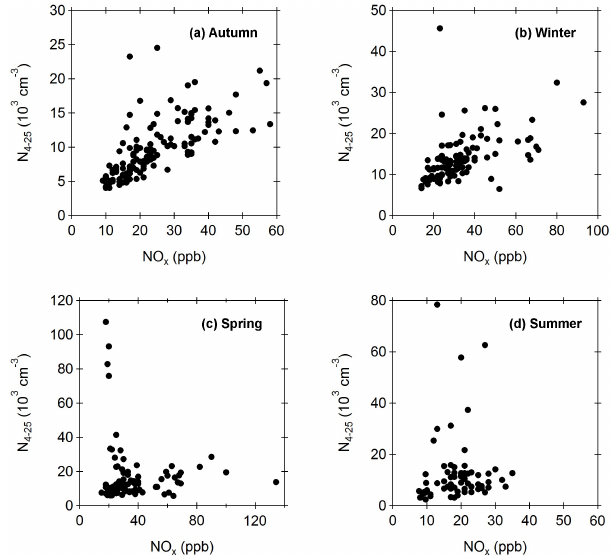
Figure 6. Scatter plots between hourly N 4 − 25 and NO x observed in (a) autumn, (b) winter, (c) spring and (d) summer at the TARO site during the period of